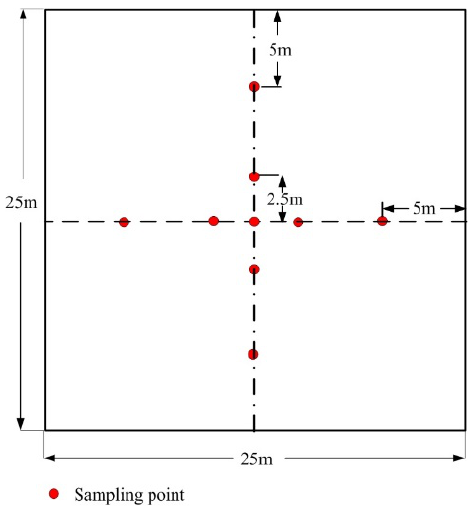
Figure 2. Sampling scheme of the digital hemispherical photography (DHP) method.